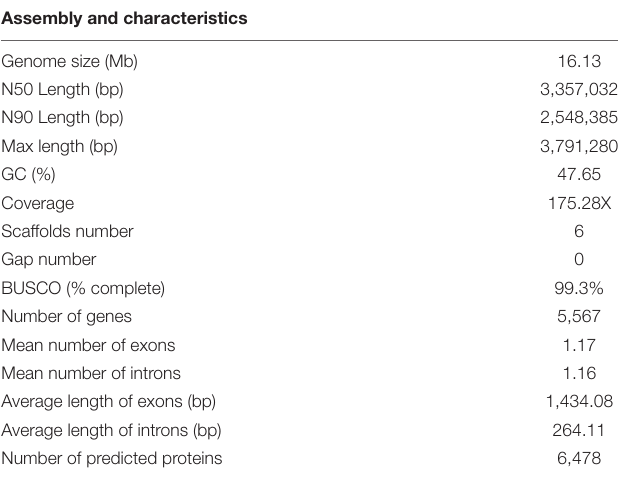
TABLE 2 | Genome characteristics of the Metschnikowia bicuspidata strain LNES0119. Assembly and